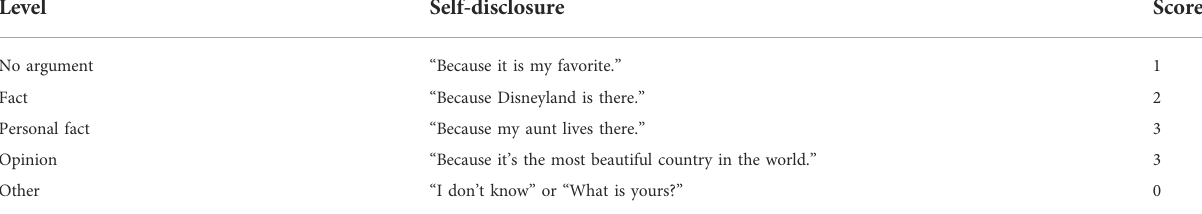
TABLE 2 Example of self-disclosed statements with an intimacy level and score assigned.